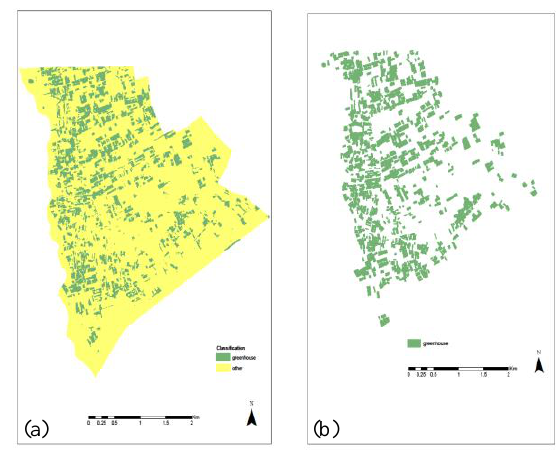
Figure 6. (a) The result of the object-based classification (b) Thematic vector data.